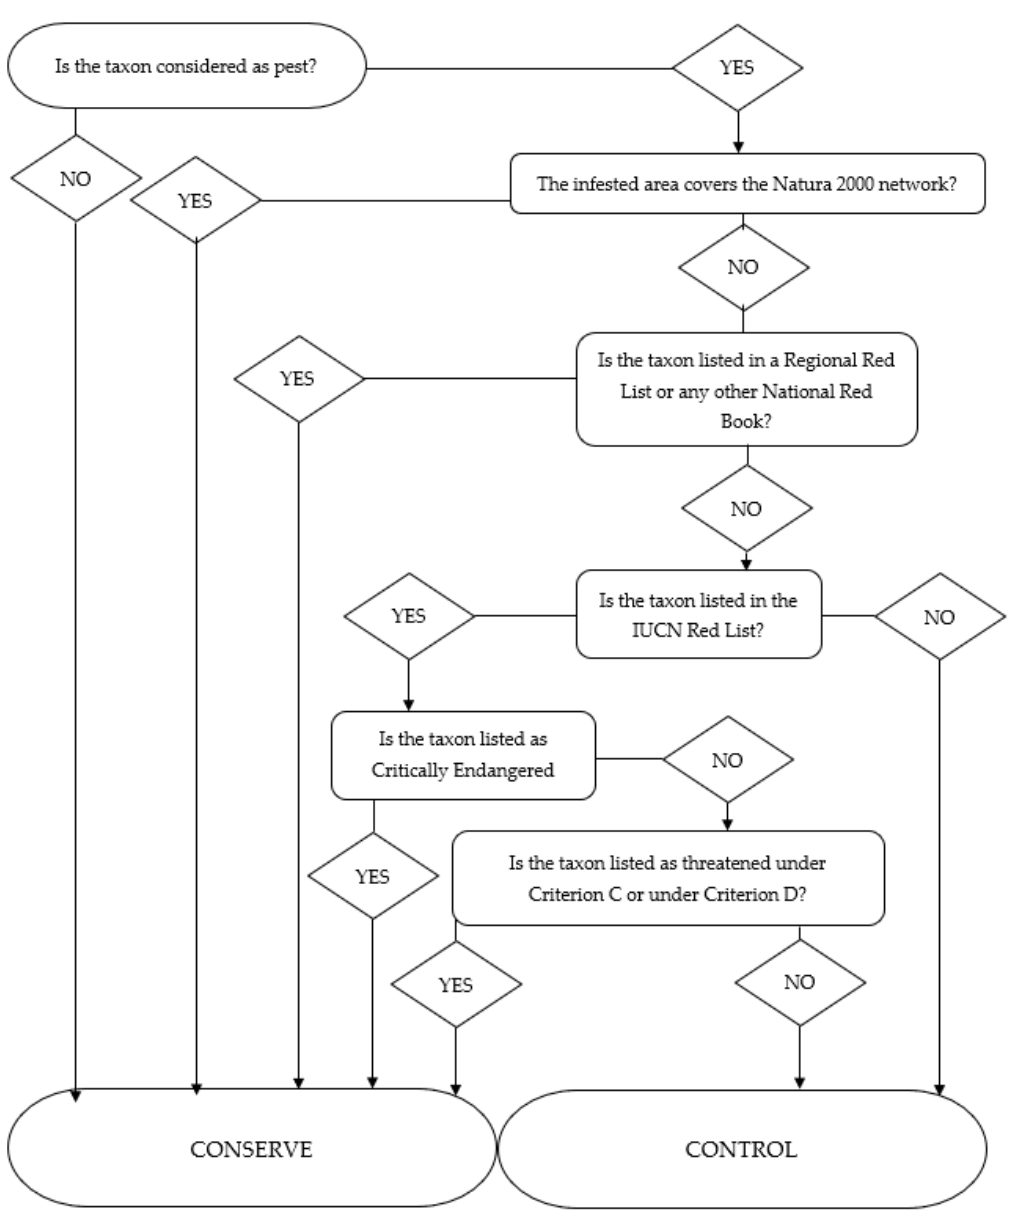
Figure 1. Simplified decision-making flowchart based on European legislation and IUCN Red List of Threatened Species for the application of control measures against saproxylic beetles that are or may be considered as pests.